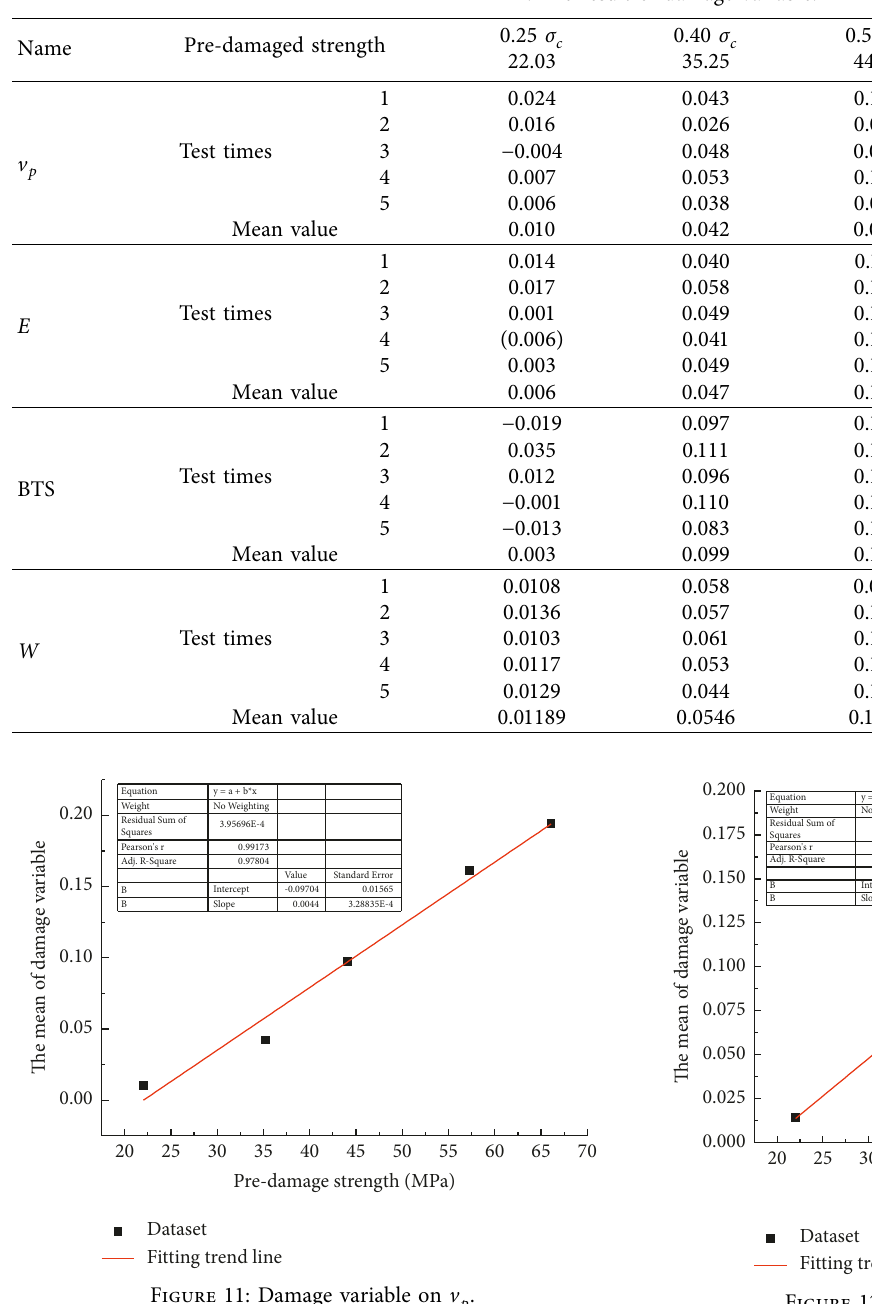
Table 4: The result of damage variable.